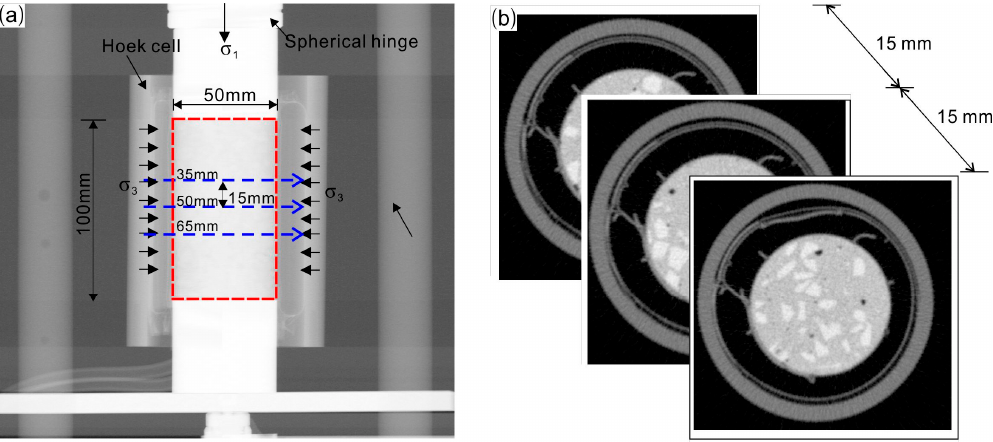
Figure 8. X-ray CT scanning positions during sample triaxial deformation. ( a ) Scheme of the scanning positions; ( b ) the reconstructed CT images before loading.